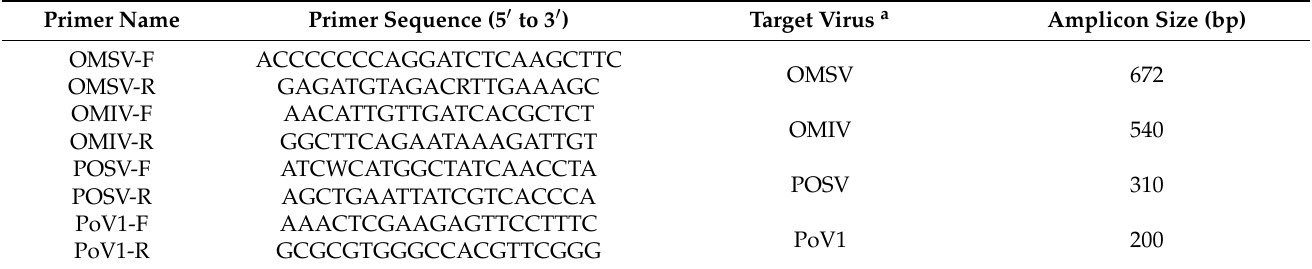
Table 1. The primers used for the multiplex detection of the four P. ostreatus